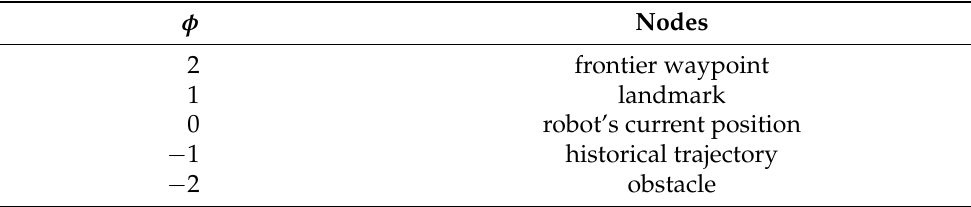
Table 1. The correspondence between flag φ and nodes.